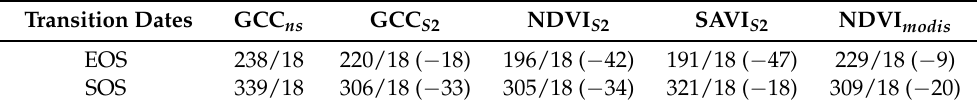
Table 5. VI Transition dates (day of year/year) and bias in relation to near-surface GCC.